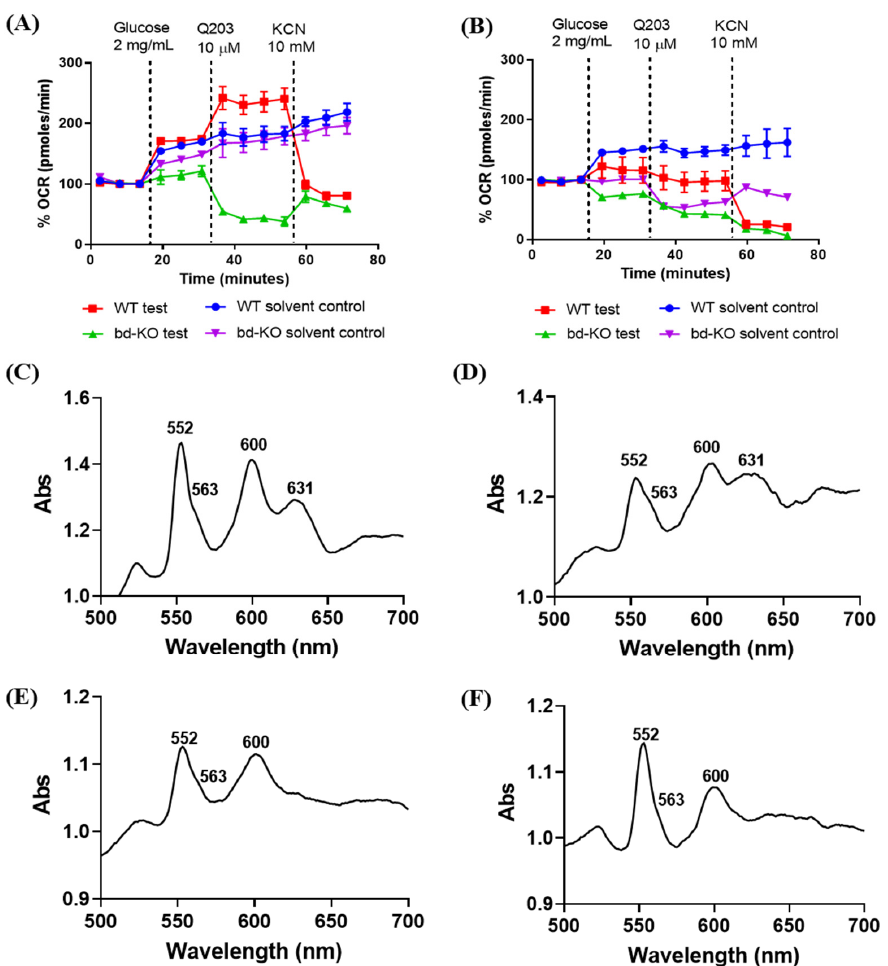
Figure 7. Impact of Q203 on the respiration and heme content of Mycobacterium smegmatis . The oxygen consumption activity of M. smegmatis WT and bd -KO strain grown with ( A ) DMSO (control) or ( B ) 10 μ M Q203. The cells were harvested in stationary phase and immobilised onto a microplate of an Extracellular Flux Analyzer. The oxygen consumption rate (OCR) was measured for three cycles, subsequently glucose (2 mg/mL), Q203 (10 μ M) and KCN (10 mM) were added at the indicated time points. The OCR after addition of glucose to energise the bacteria (typically 60 pmol/min for WT and 40 pmol/min for bd ‐ KO grown in presence of DMSO and 150 pmol/min and 60 pmol/min for bd ‐ KO grown in presence of Q203) was set to 100%. Three biological replicates were performed, results from one representative biological replicate are shown, error bars show standard deviations of values from two technical replicates/wells. ( C – F ) Reduced ‐ minus ‐ oxidised spectra of membrane fractions isolated from M. smegmatis WT and bd ‐ KO grown in presence of ( C , E ) DMSO (untreated control) and ( D , F ) 10 μ M Q203, respectively. Samples were reduced by the addition of sodium di ‐ thionite and oxidised using potassium ferricyanide. Taken together, under the conditions tested here, the putative second cytochrome bd variant AppCB exhibited markedly different properties as compared to CydAB.